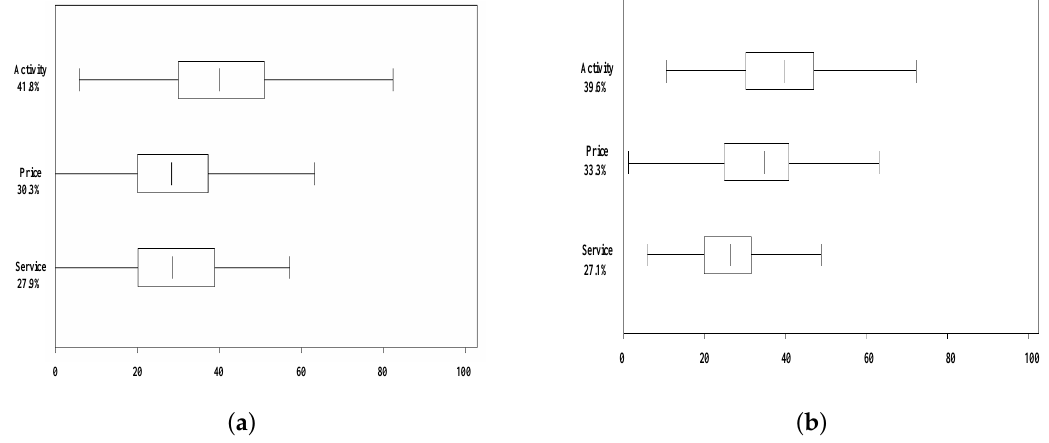
Figure 2. Relative importance of attributes (( a ) Dalishu scenic spots; ( b ) Qingshan scenic